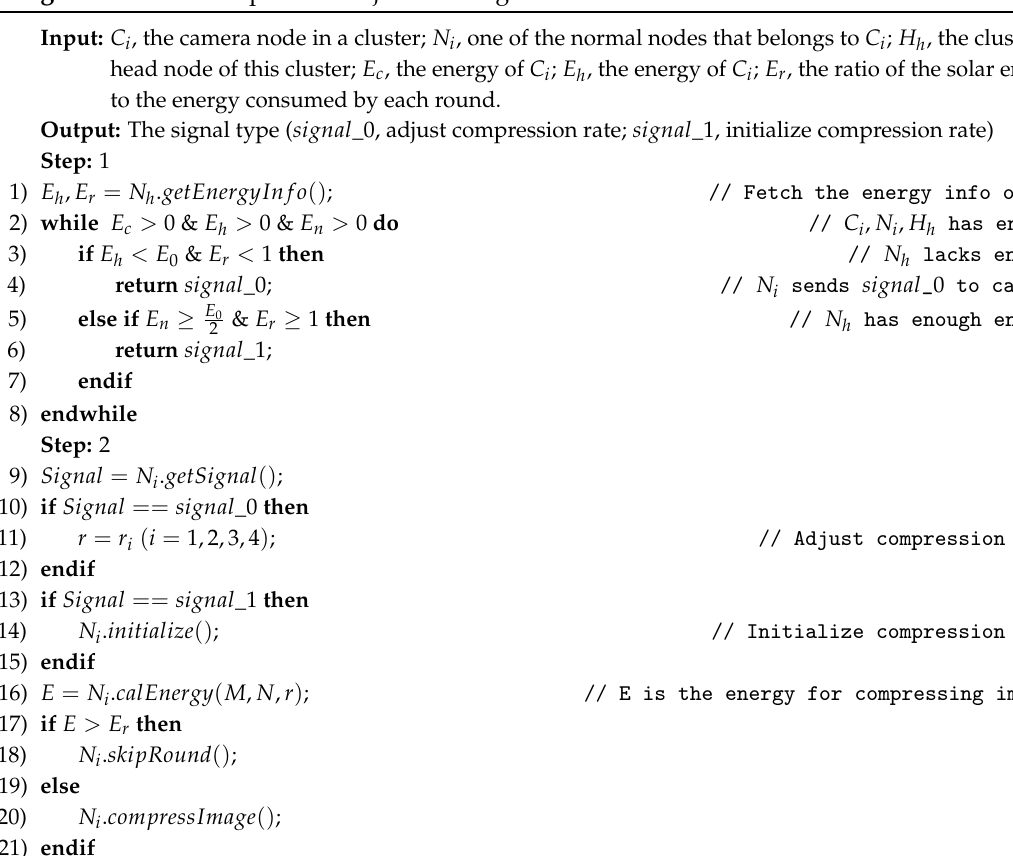
Algorithm 3: The cooperative adjustment algorithm of normal nodes and cluster head